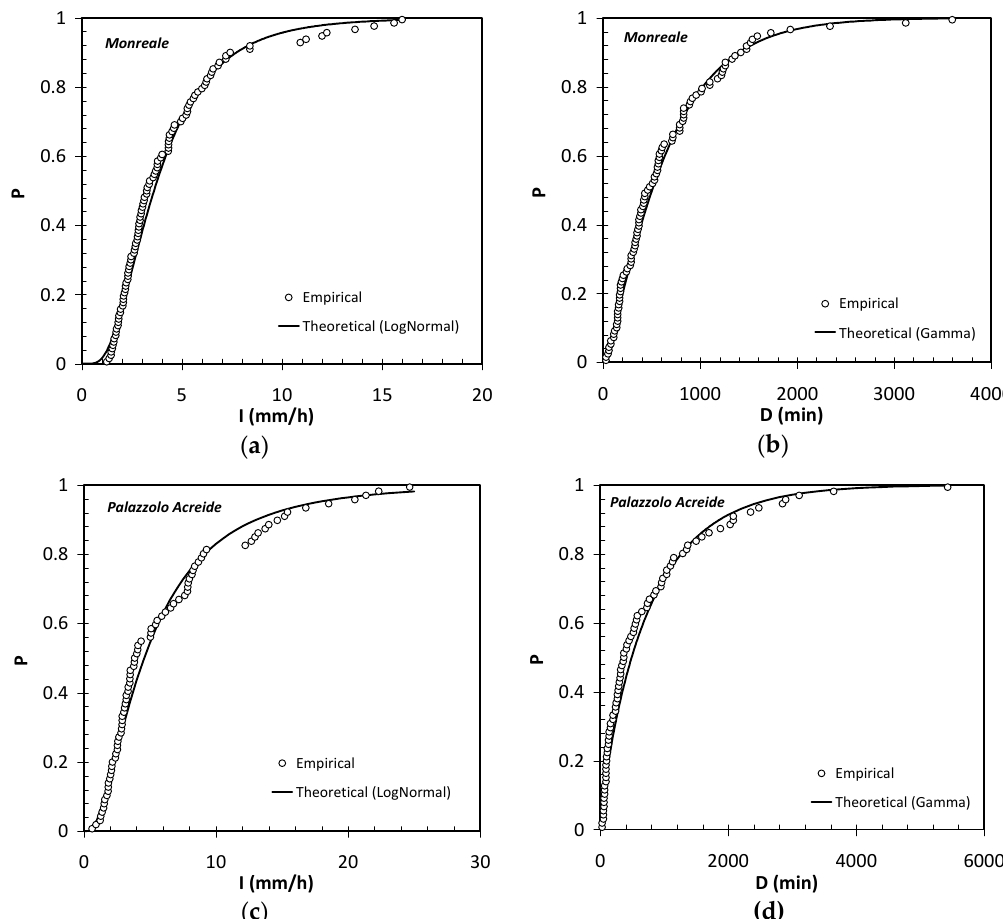
Figure 6. Plotting position: ( a ) average intensity at Monreale; ( b ) duration at Monreale; ( c ) average intensity at Palazzolo Acreide; ( d ) duration at Palazzolo Acreide.